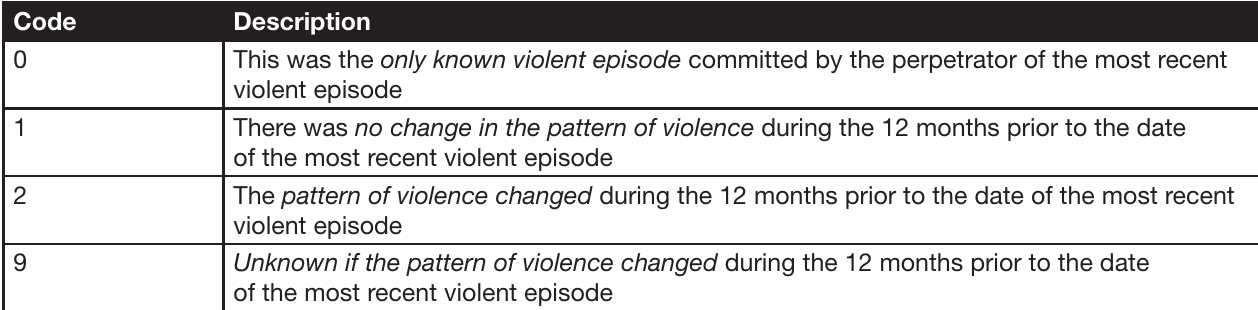
INTIMATE PARTNER VIOLENCE: UNIFORM DEFINITIONS AND RECOMMENDED DATA